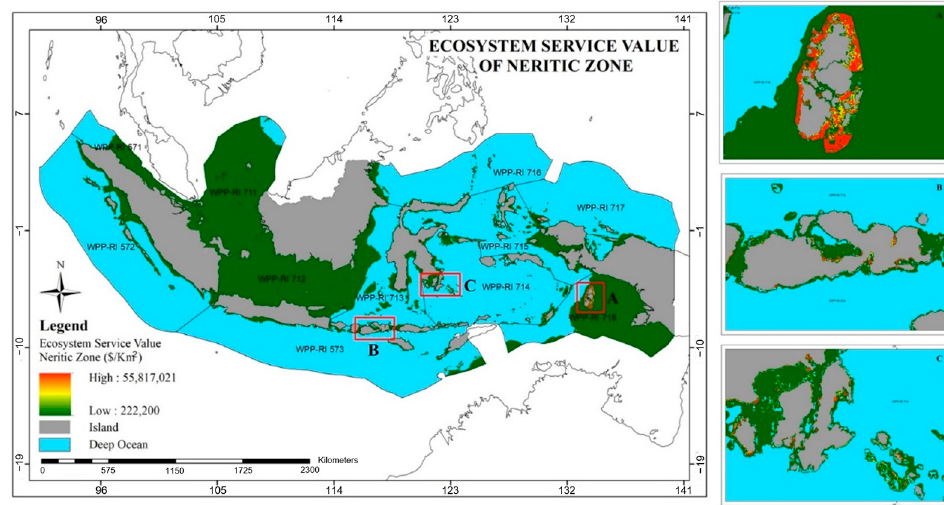
Figure 3. Map depicting the spatial model of marine ecosystem services value in the Indonesian neritic zone. ( A ) Aru Islands. ( B ) Nusa Tenggara Islands. ( C ) Southeast Sulawesi region.